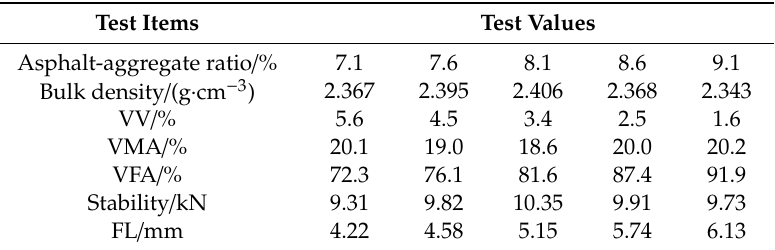
Table 7. Marshall test results of SMA-II-2.